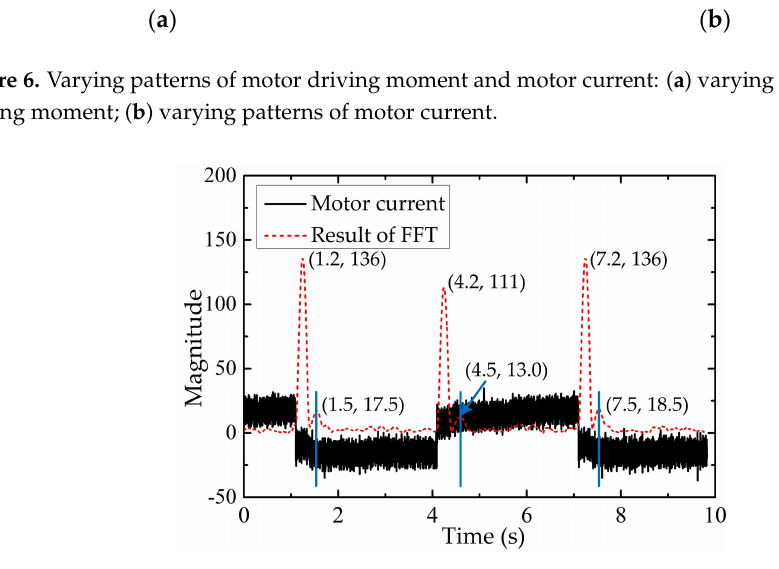
Figure 7. The result of FFT for the first non-zero frequency.